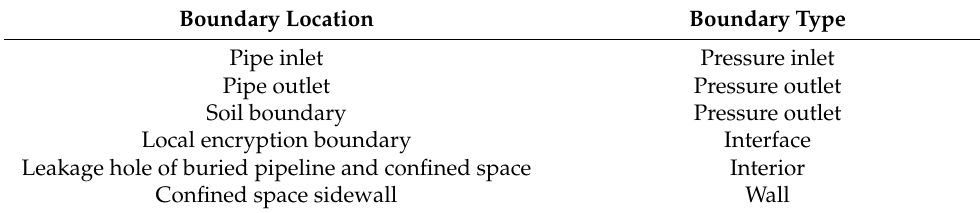
Table 2. Boundary condition definition.